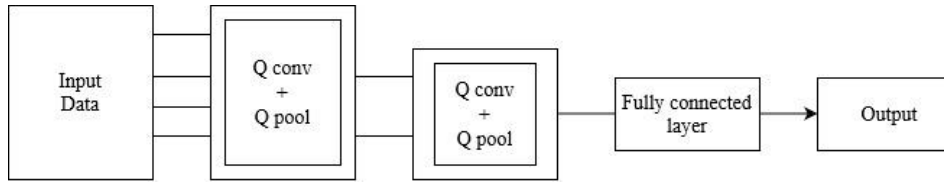
Figure 1. Prediction method with Q conv, Q pool, and full connection layer. Q conv and Q pool represent the convolutional layer and polling layer,